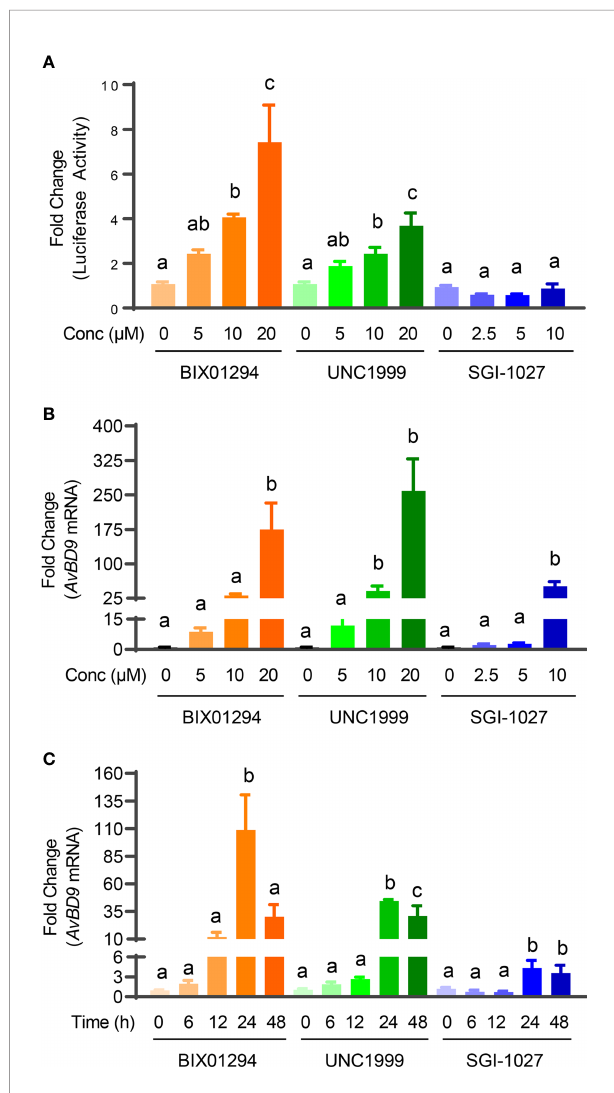
FIGURE 2 | Concentration- and time-dependent induction of AvBD9 mRNA expression by HMTi or DNMTi. (A) Fold changes in relative luciferase activity in stable chicken HTC/ AvBD9-luc luciferase reporter cells in response to indicated concentrations ( m M) of each compound for 24 h. (B) Fold changes in the AvBD9 mRNA expression level in chicken HTC cells stimulated with indicated concentrations of each compound for 24 h. (C) Fold changes in the AvBD9 mRNA expression level in chicken HTC cells stimulated with 10 µM of each compound for indicated lengths of time. AvBD9 mRNA expression was analyzed using RT-qPCR. Results are shown as means ± SEM of three independent experiments. The bars not sharing a common superscript are considered signi fi cantly different ( P < 0.05) based on one-way analysis of variance and post hoc Tukey ’ s